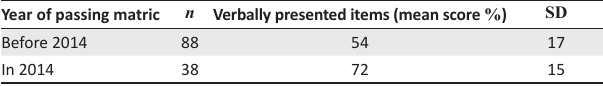
TABLE 3: Performance of students in the verbally presented items in relation to pre-2014 matriculants of and the matriculants of 2014. Year of passing matric